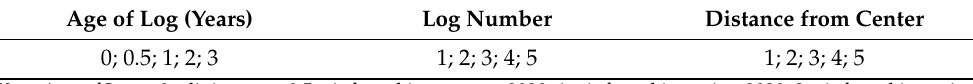
Table 1. Marking of Samples.